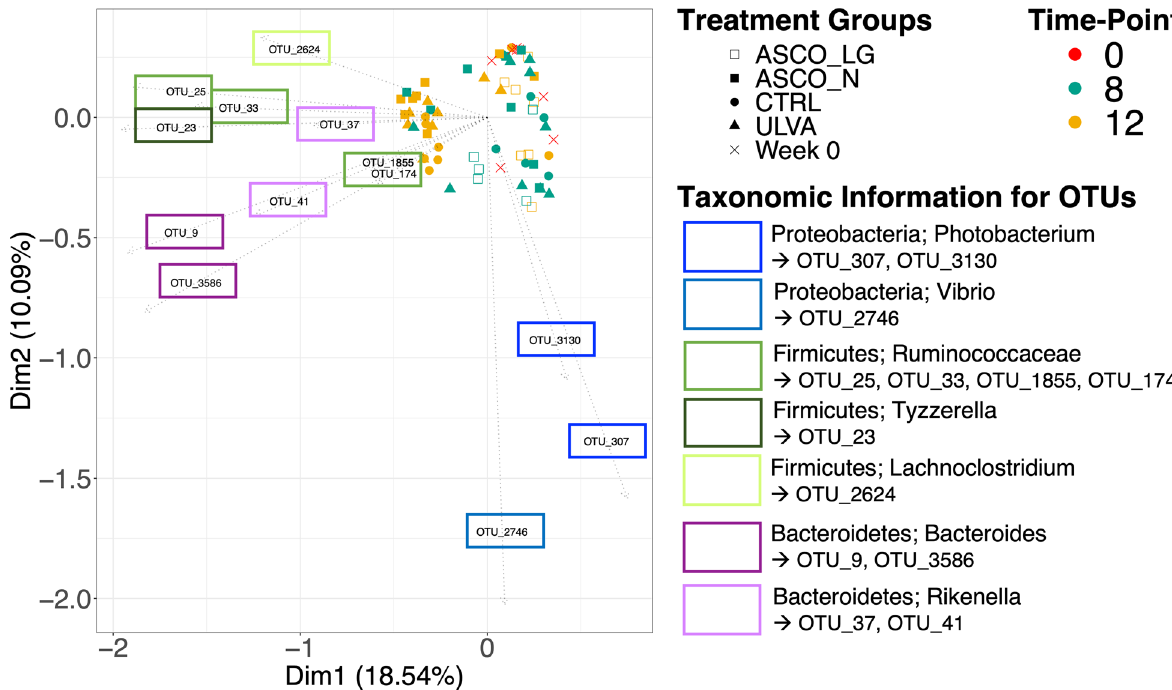
Fig. 1 Temporal dissimilarity of the gut microbiota of Atlantic cod. Dissimilarity is explained by Proteobacteria species at Week 0/Week 8 and Bacteroidetes and Firmicutes species at Week 12. The points represent grouped samples with ‘ Time ’ denoted by colour; 0 (red), 8 (green), 12 (orange), and dietary treatments denoted by symbols. Deviance in ordination space is explained by 24.5%. PERMANOVA (sources of variability explained by dissimilarities between samples) showed that variation accounted for by Treatment Groups; R2 = 0.098, *** p = 0.001 and variation accounted for by Time-Point; R2 = 0.08644, *** p =